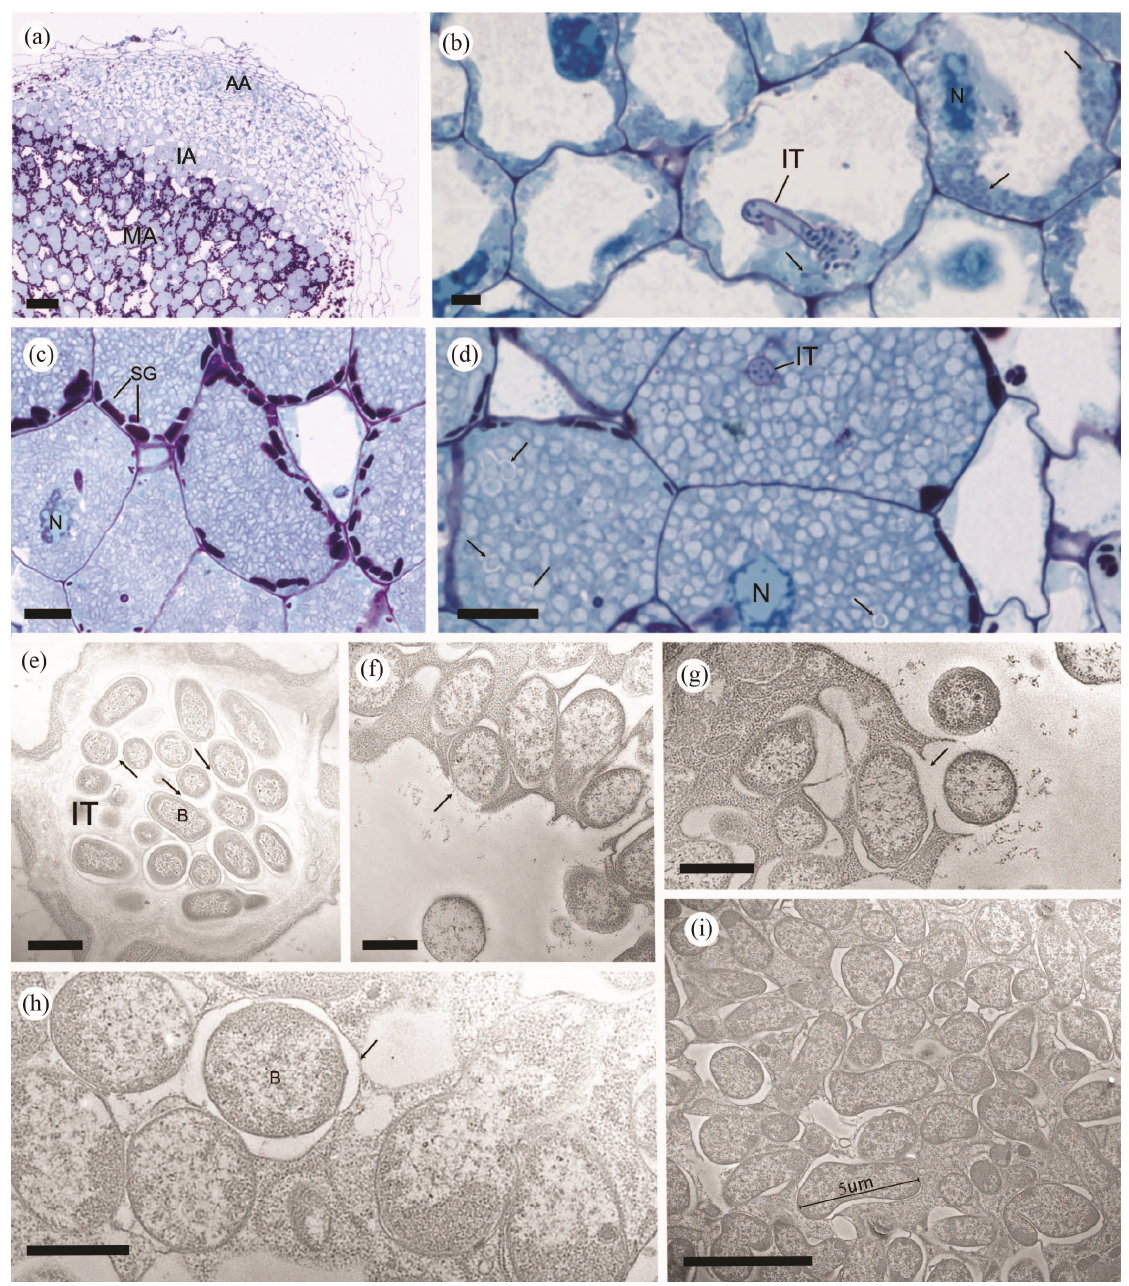
Figure 6. Detailed structural and ultrastructural analysis of a nodule formed after inoculation of peas with Sphingomonas sediminicola . ( a ) Light microscopic photograph of a nodule showing different cell types characterising an apical area (AA), an interzone (IA), and a mature area (MA), with the latter two containing symbiosomes. ( b ) Detail of an infection thread (IT) invading the cell and releasing a bacterium in the apical zone. ( c , d ) Enlargements of the symbiosomes in the cells of the central zone of the nodule. Arrows underline obvious symbiosome structures (N) indicating cell nuclei and (SG) starch granules. ( e – i ) Ultrathin sections of nodules taken with a transmission electron microscope. ( e ) Cross-section of an infection thread (IT) with free-living bacteria (B) inside an electron transparent matrix (arrows). The presence of bacteroids surrounded by a peribacteroid membrane can be seen in ( f , g ), together with the appearance of an endocytosis process (arrows). ( h ) Detail of a symbiosome consisting of bacteria (B) clearly isolated from the host cytoplasm by a surrounding membrane (arrow). ( i ) Details of fully enlarged and differentiated symbiosomes in the mature area of the nodules. Bars represent 100 µ m ( a ), 10 µ m ( b – d ), 1 µ m ( e – h ), and 5 µ m ( i